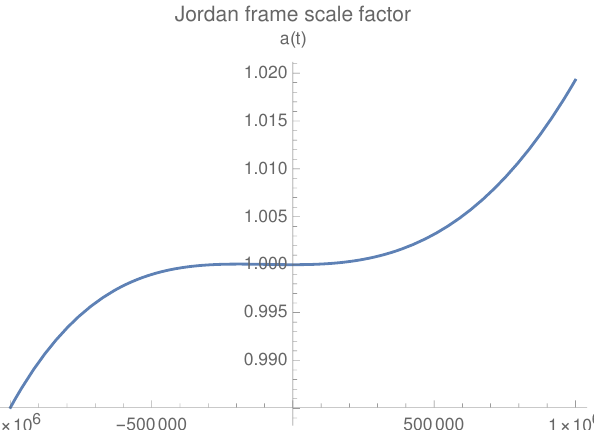
Figure 20. Time evolution of the scale factor in the Jordan frame in vacuum background in exponential gravity found with the conditions H ( 0 ) = 0, ˙ H ( 0 ) = 10 − 14 , ¨ H ( 0 ) = 10 − 19